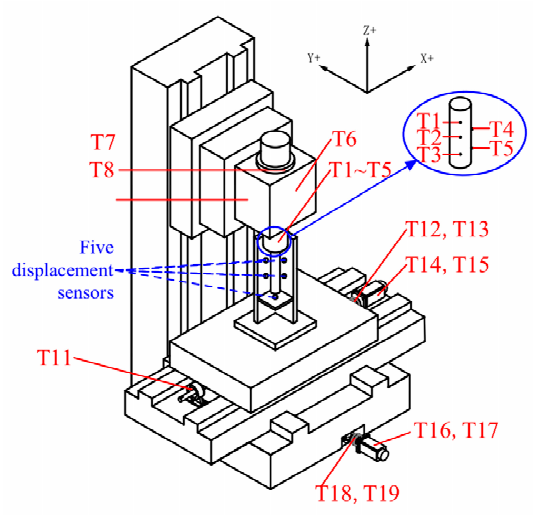
Figure 2. Sensor layout in the experimental object. Table 1. Detailed installment location of sensors.